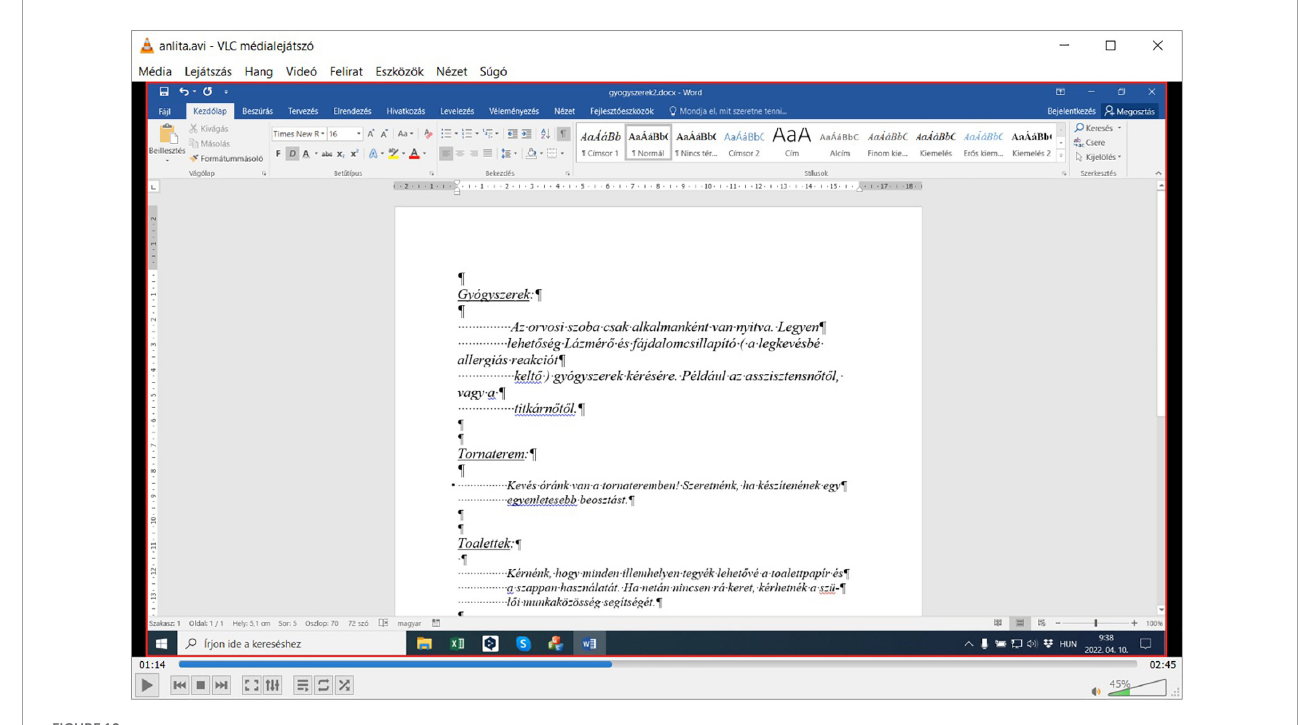
FIGURE10 Video playback of what ANLITA (or rather FFmpeg) recorded when Figure 9 was logged.